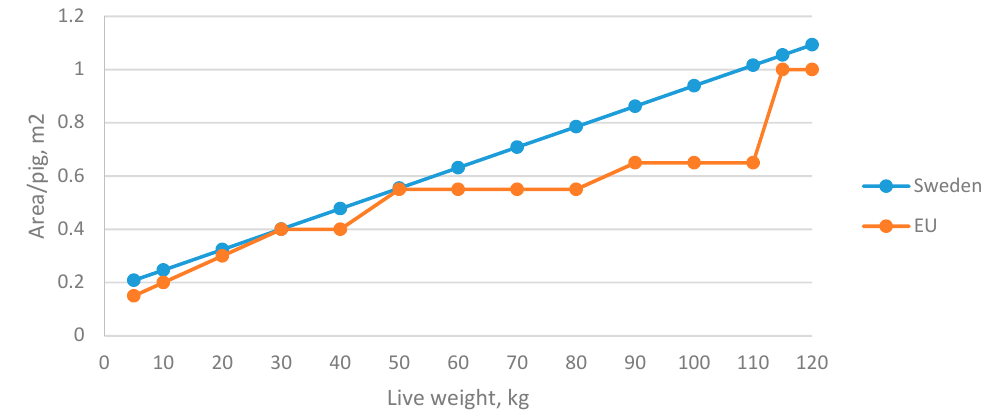
Figure 1. Minimum stocking density requirement for growing pigs in the European Union (EU) and in Sweden. Note that weaning weight in Sweden is ~10 kg live weight (LW) and pigs < 10 kg LW are commonly still housed with their dams in the farrowing pen, while weaning weight in the EU is < 10 kg LW (due to lower weaning age) and hence piglets are moved to grower pens at lower LW.